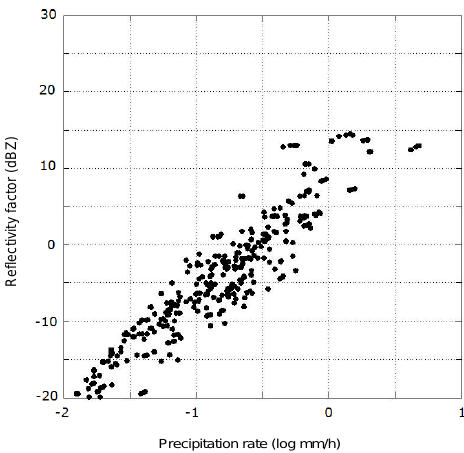
Fig. 8. Relationship between the reflectivity factor and the precipi- tation rates derived from CPI